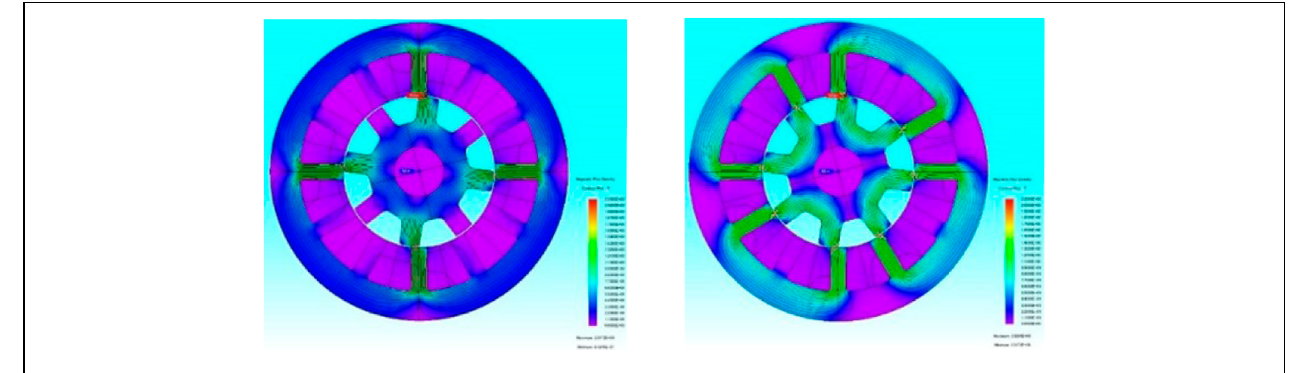
FIGURE 1 | Three-phase 12/8 pole SRM flux density distribution map.